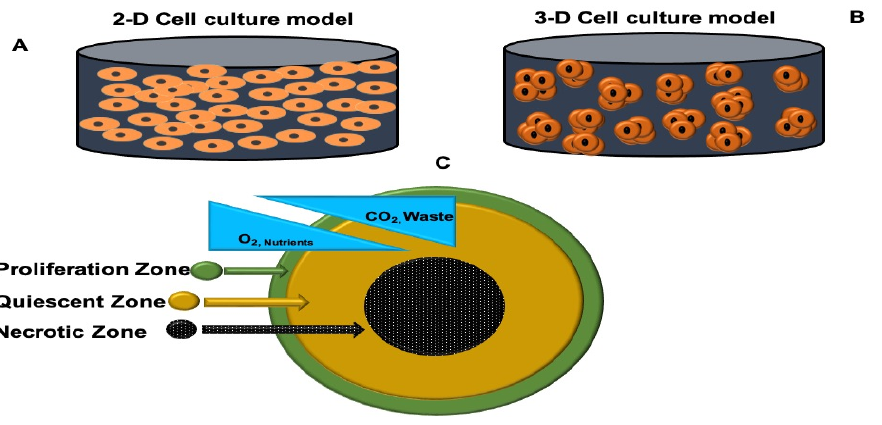
Figure 1. Representation of 2D and 3D cell culture platforms. ( A ) Traditional monolayer cell culture; ( B ) 3D cell culture system; ( C ) distinct layers of a spheroid.